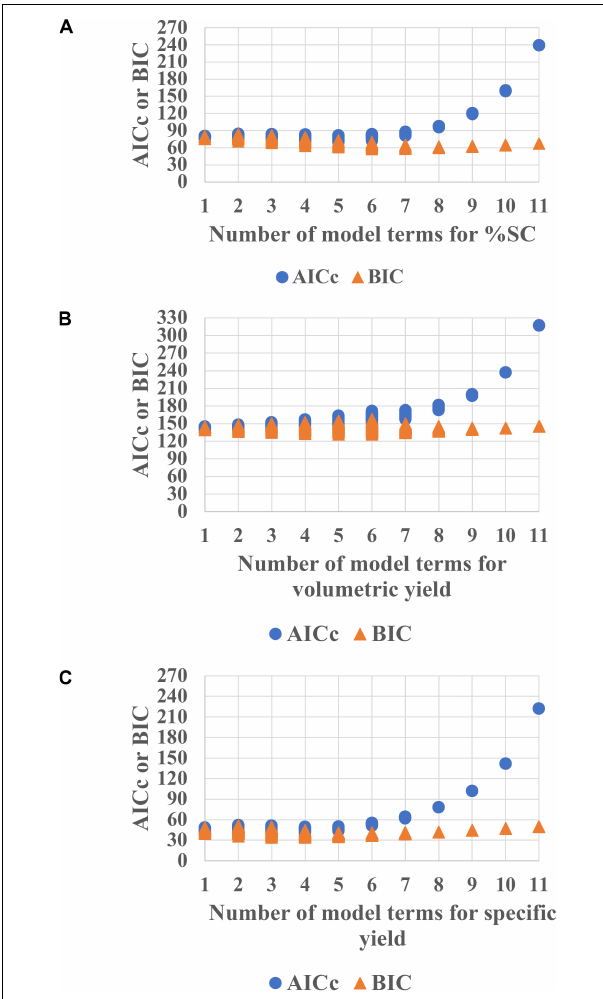
FIGURE 2 | AICc and BIC plots for each attribute (A) %SC, (B) volumetric yield, and (C) specific yield for E. coli pTH.PRRSV_GP5. The lower values of AICc and BIC indicate better model prediction. Hence, models with the number of term of 4–6 are expected to provide sufficient prediction capability for %SC, whereas 4–6 terms and 3–5 terms are for volumetric yield prediction and specific yield models, respectively.